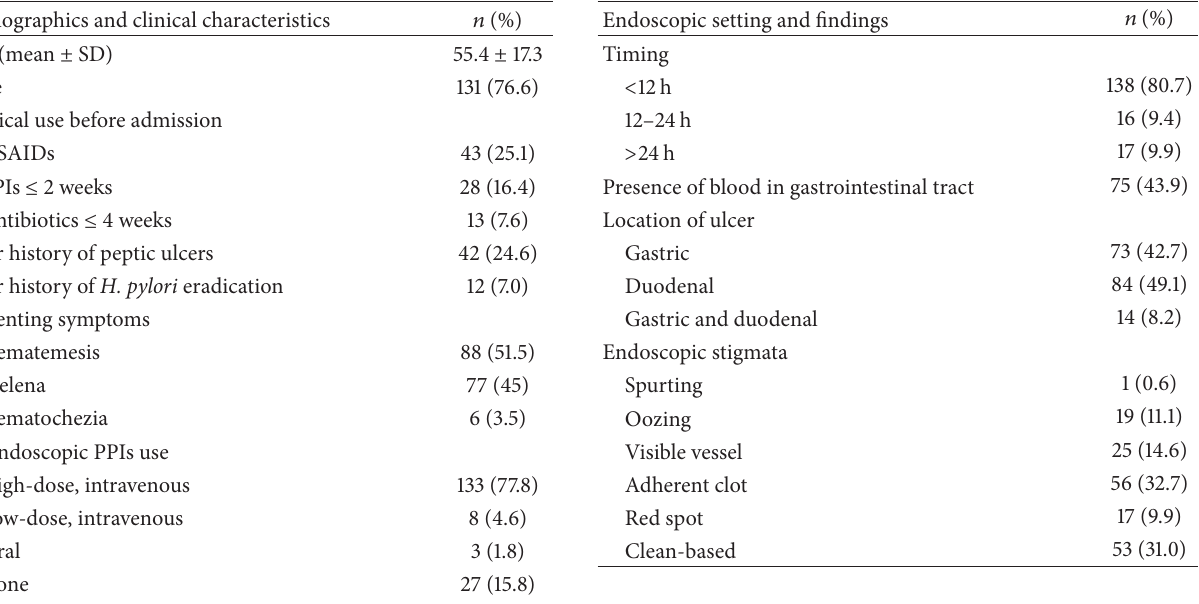
Table 1: Demographics and clinical characteristics ( 𝑛 = 171 ). Table 2: Endoscopic setting and findings ( 𝑛 = 171